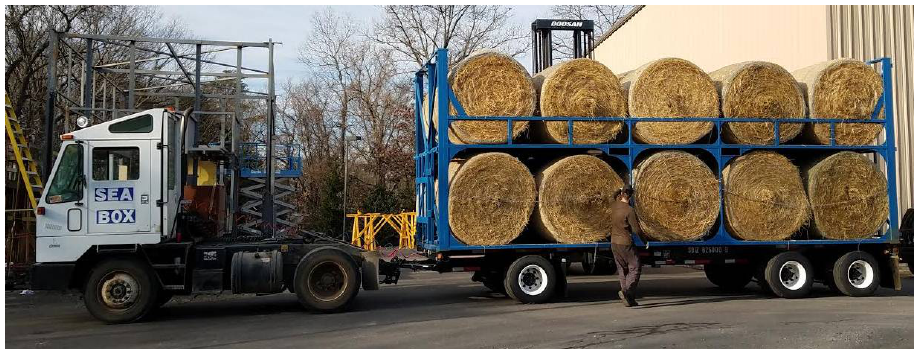
Figure 1. Prototype rack and trailer (Sea Box